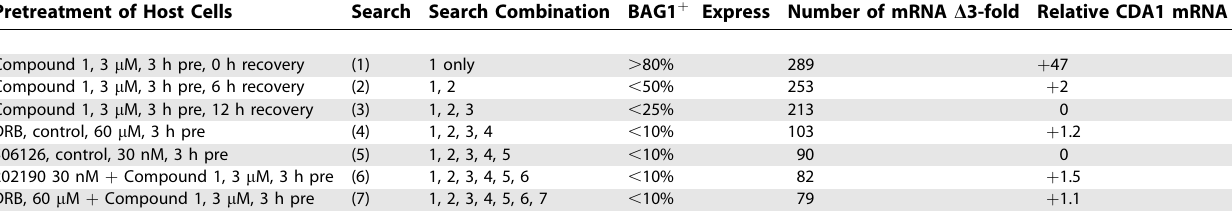
Table 1. Multivariate Microarray Analyses Were Used to Correlate Changes in the Levels of Host Cell mRNAs with Distinct Parasite Developmental Outcomes to Identify mRNAs Most Relevant to the Compound 1 Induction of Bradyzoite Development Pretreatment of Host